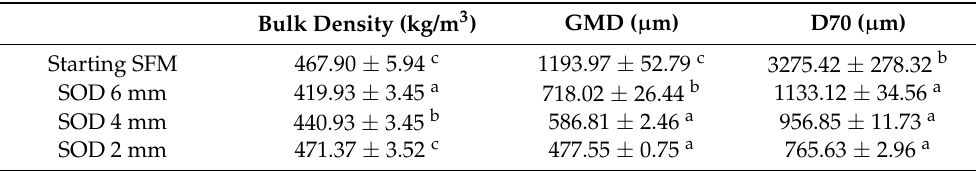
Table 2. Physical properties of starting and hammer milled